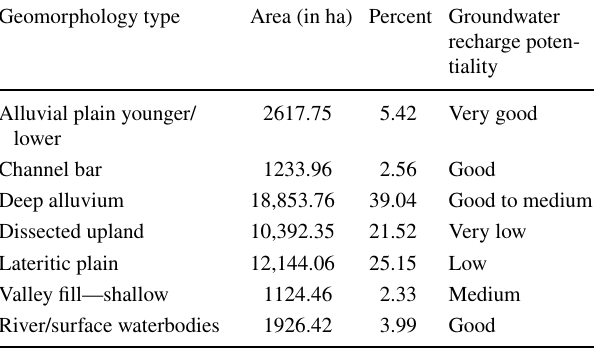
Table 5 Geomorphological characteristics and their areal extent of Gopiballavpur block, Paschim Medinipur, West Bengal, India